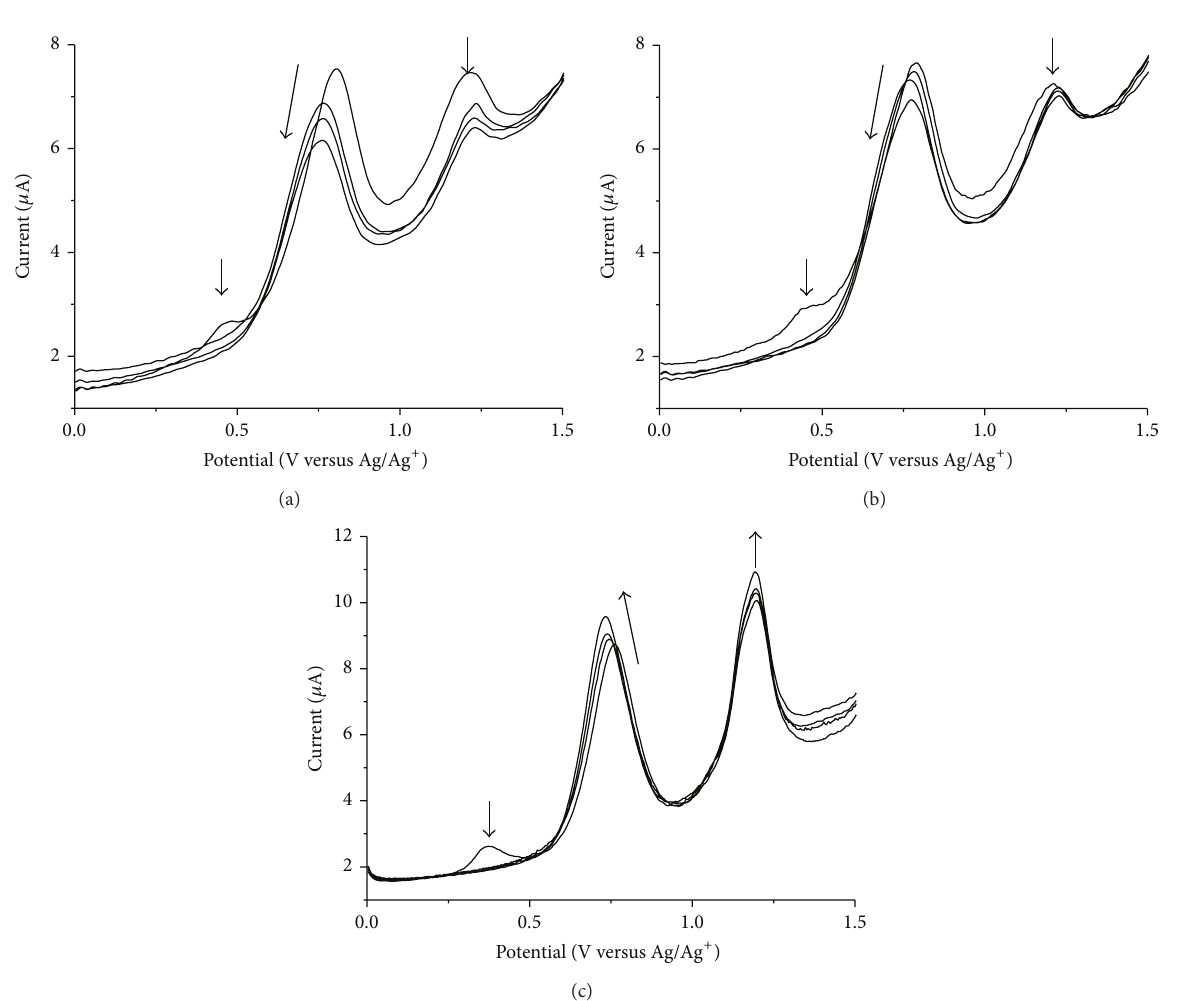
Figure 5: DPVs of o -CAC (1 × 10 −4 M) upon the addition of increasing amount of (a) Sr 2+ and (b) Zn 2+ , and (c) DPVs of o -EAC upon the addition of increasing amount of Cr 2+ . [M 2+ ] = 0.5, 1.0, and 1.5 × 10 −4 M. Pulse amplitude: 50 mV, pulse width: 0.05 sec, sample width: 0.0167 sec, and pulse period: 0.2